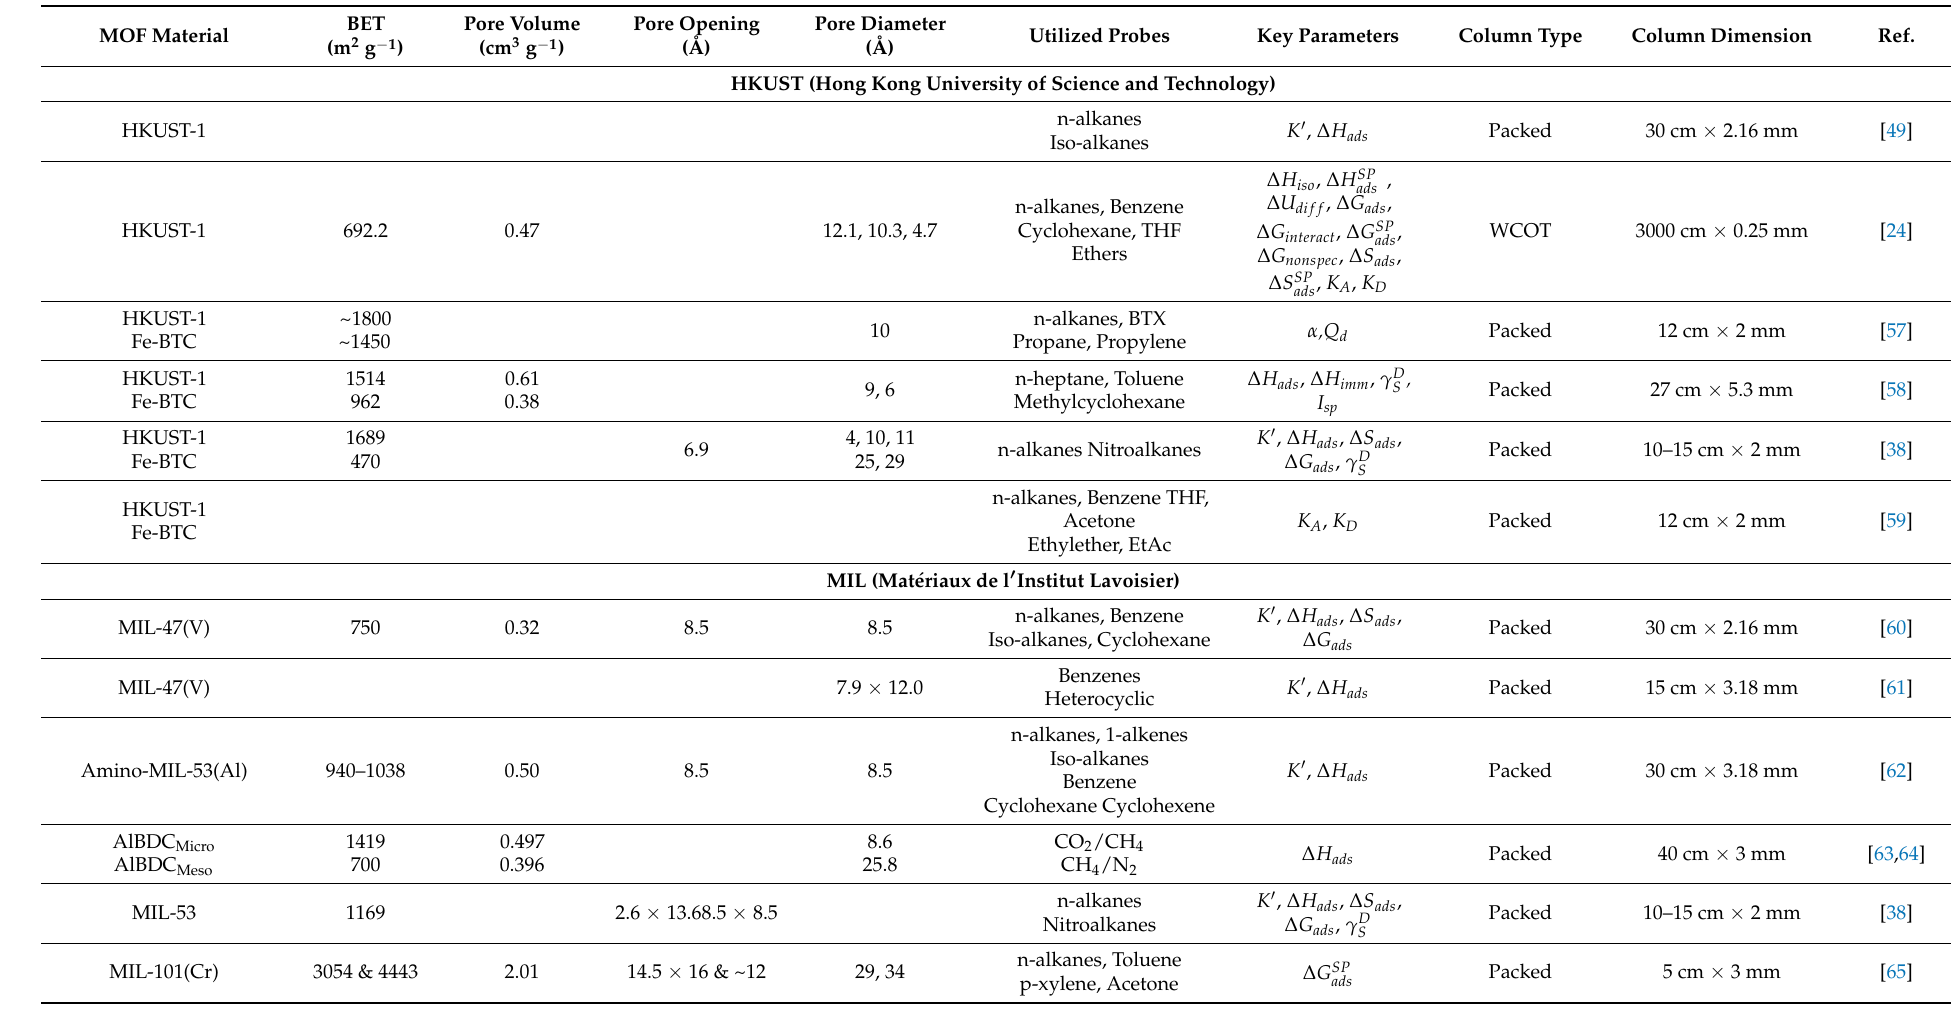
Table 1. The most significant applications of IGC for physicochemical characterization of